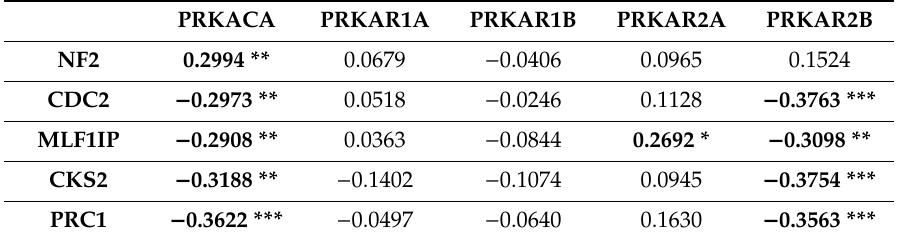
Table 2. Correlation of PRKA subunits’ gene expression levels with meningioma-related genes (Pearson’s R values. Significant correlations are in bold and marked by * p < 0.05, ** p < 0.02, *** p < 0.005).